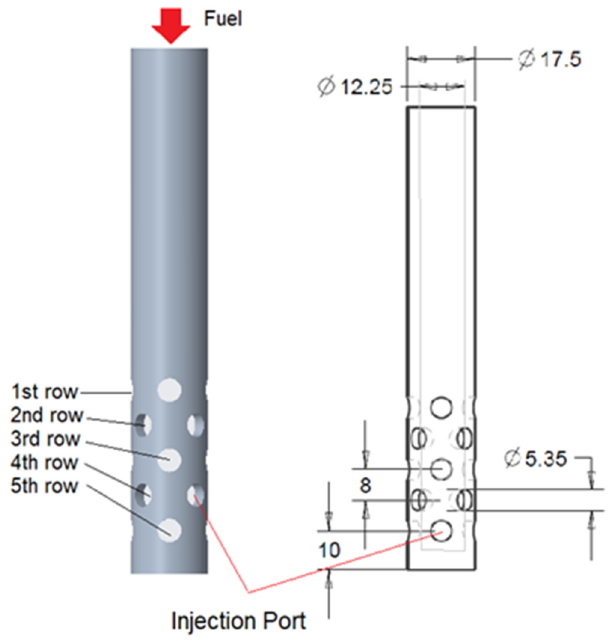
Figure 3. Schematic of the model injector with the ports and its dimension.